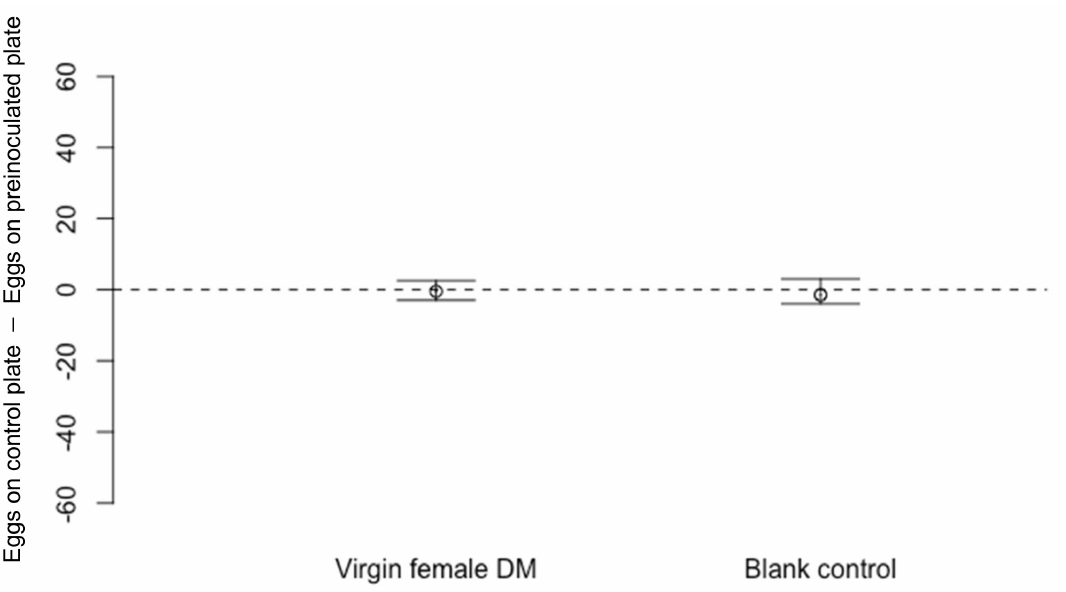
Figure 2. Differences in numbers of eggs laid by Drosophila suzukii (Median ± 95% confidence intervals) on cornmeal media dishes previously exposed for 48 h to virgin D. melanogaster (DM) females cmpared to a blank dish not previously exposed to flies ( n = 17, p = 0.83). In the control experiment, D. suzukii laid a similar number of eggs on both blank dishes that were not exposed to D. melanogaster previously ( n = 17, p = 0.67).